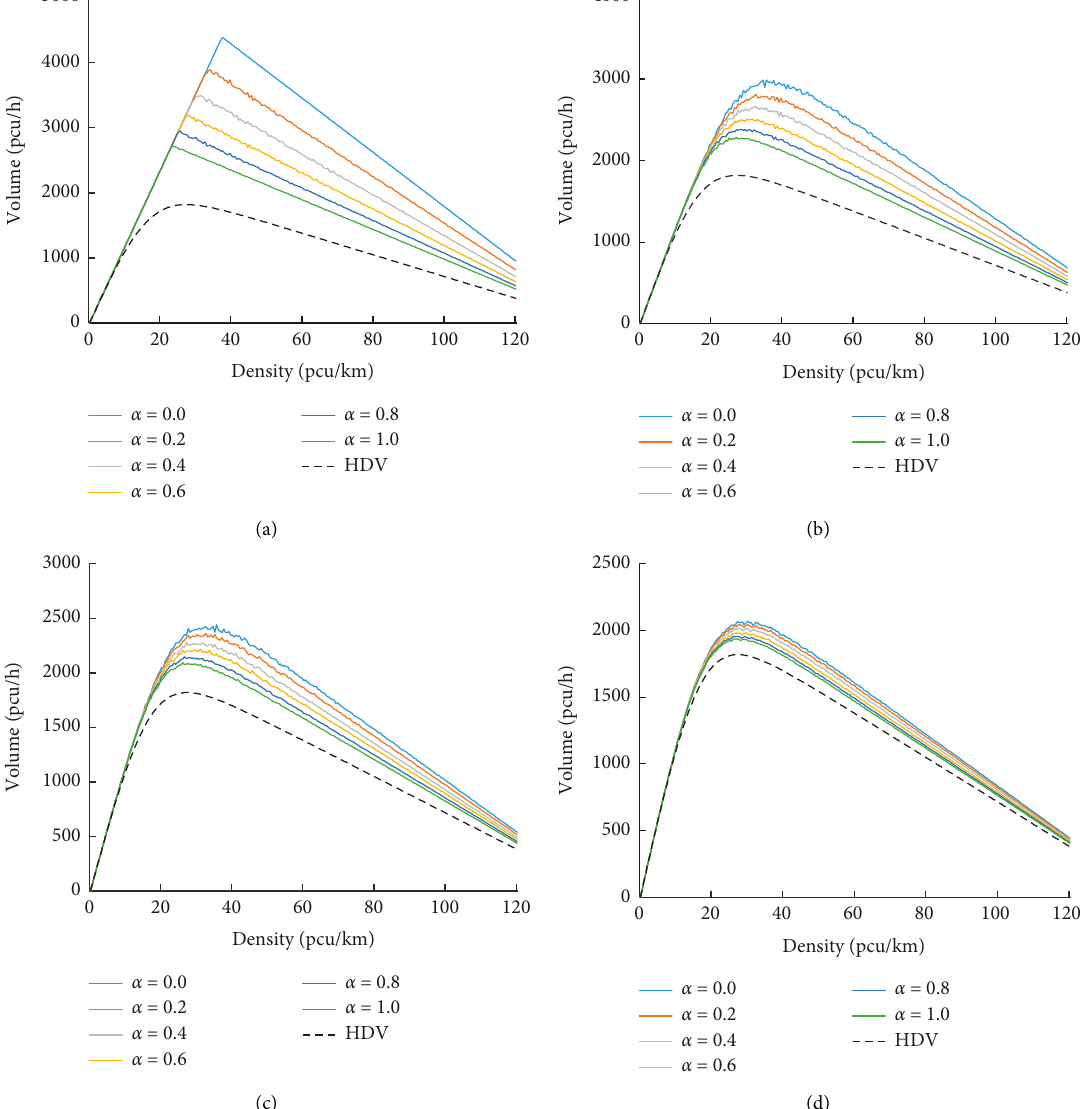
Figure 10: Traffic capacity with multiple penetration rates under transmission delay. (a) No HDVs. (b) 25% HDVs. (c) 50% HDVs. (d) 75%